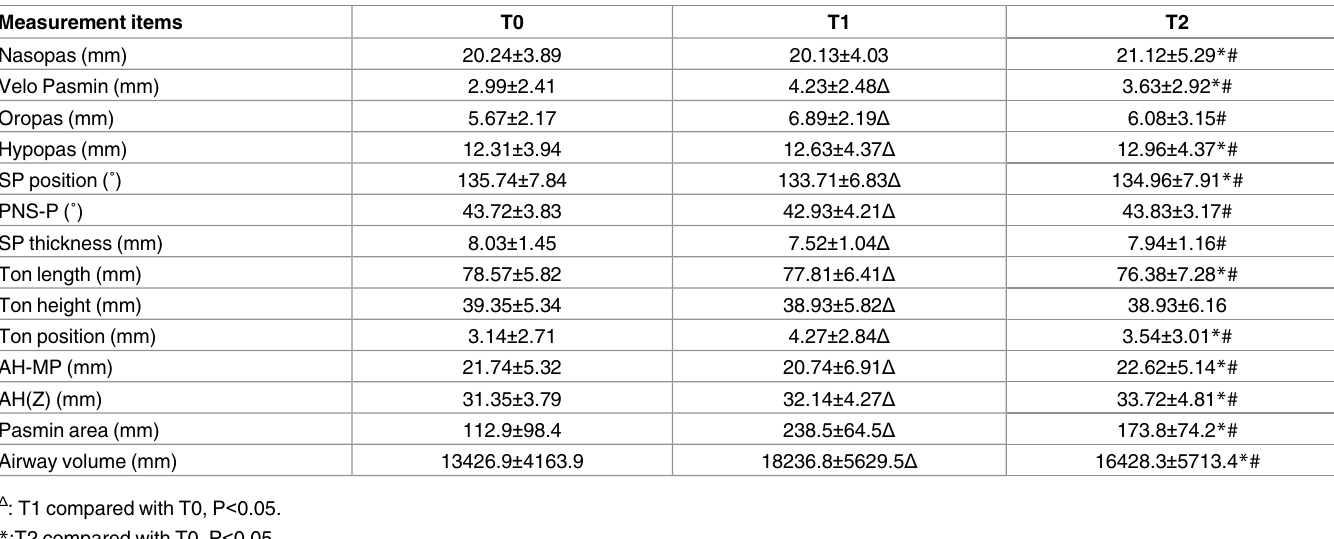
Table 3. The items related to the upper airway at the three time points before and after autogenous coronoid process graft reconstruction for the treatment of unilateral temporomandibular joint ankylosis. Measurement items